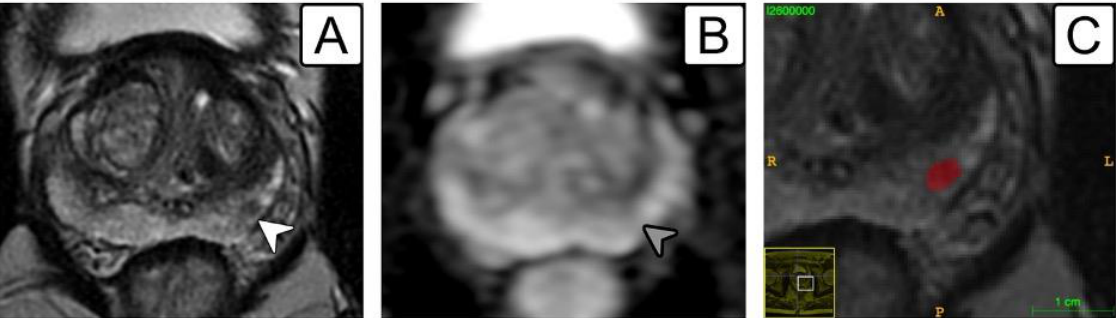
Figure 3. A 64-year-old patient with a PI-RADS 3 lesion in the left mid-gland peripheral zone. ( A ) Lesion on T2-w sequence depicted as a low-signal 5-mm nodule (white arrowhead); ( B ) same lesion highlighted on ADC map (grey arrowhead); ( C ) manual segmentation on ITK-SNAP (red label). Target biopsy revealed fibrosis with focal atrophy without evidence of prostate cancer.